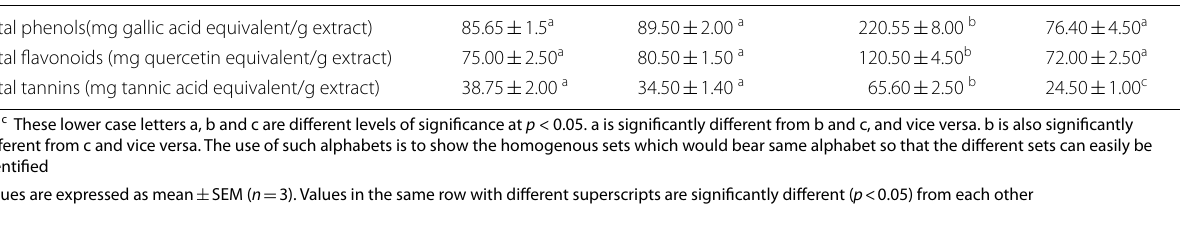
Table 6 Quantification of phytochemicals of fractions from leaf extracts of I. gabonensis Phytochemical Hexane Total phenols (mg gallic acid equivalent/g